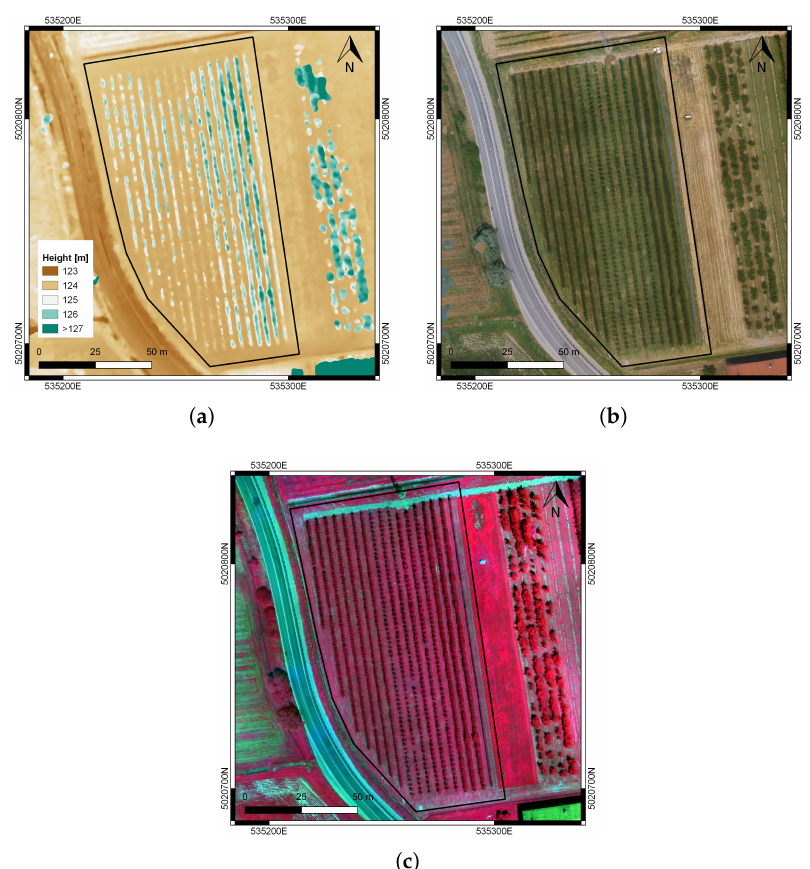
Figure 5. Pear orchard site: DSM ( a ) and orthophoto ( b ) produced through photogrammetric processing of the RGB dataset; false color orthophoto ( c ), generated from the multispectral